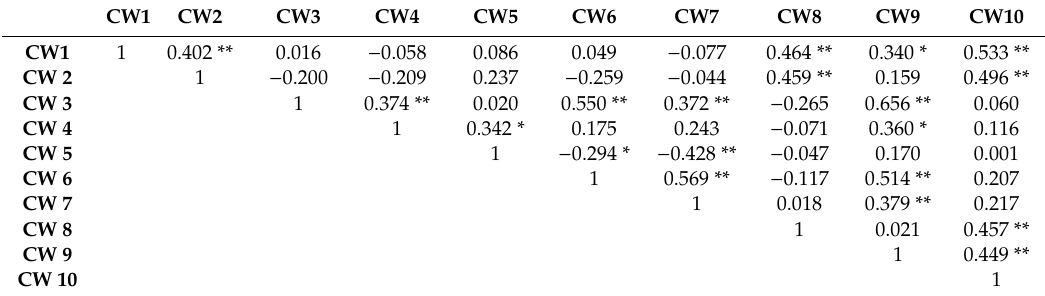
Table 5. Correlation coe ffi cient matrix with significance of the CWERAF.